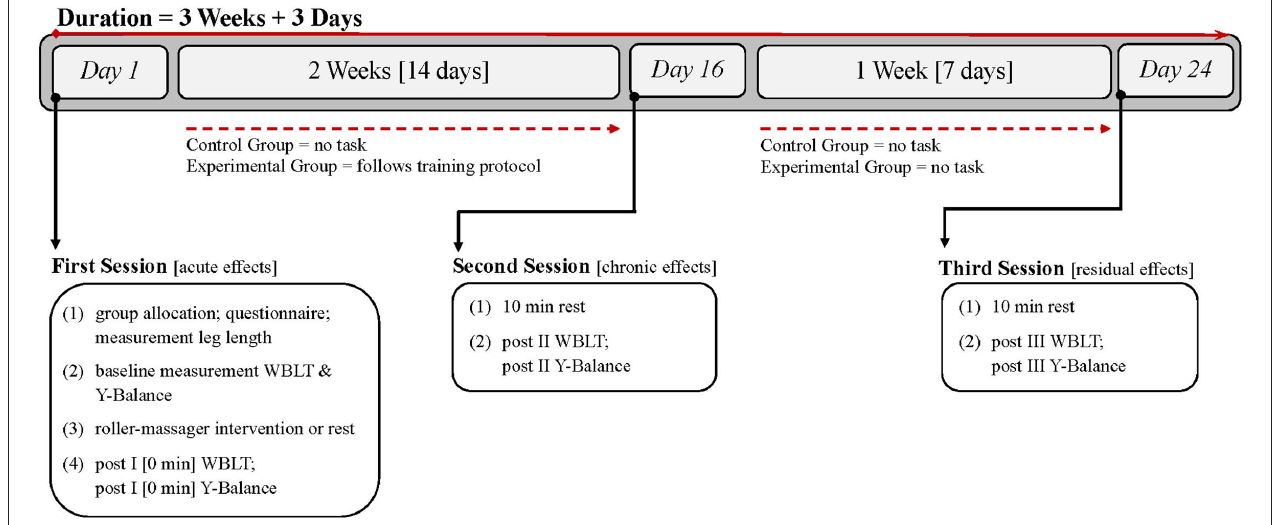
FIGURE 1 | Timeline of measurements and intervention.